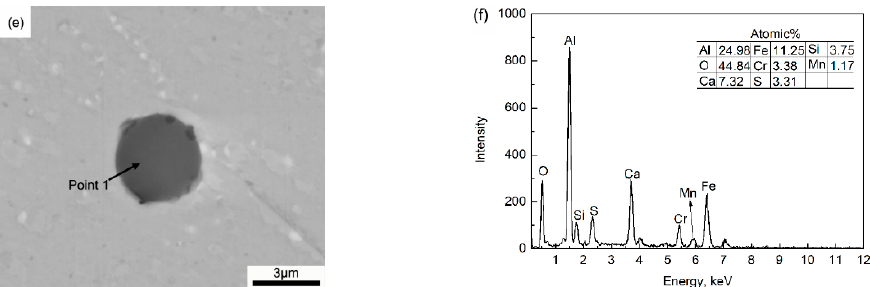
Figure 8. SEM images and compositions of primary carbides and inclusions: ( a , b ) MnS inclusion containing primary carbide, ( c , d ) MnS and Al 2 O 3 inclusions containomg primary carbide, and ( e , f ) CaO ∙ Al 2 O 3 inclusion (online version in color).